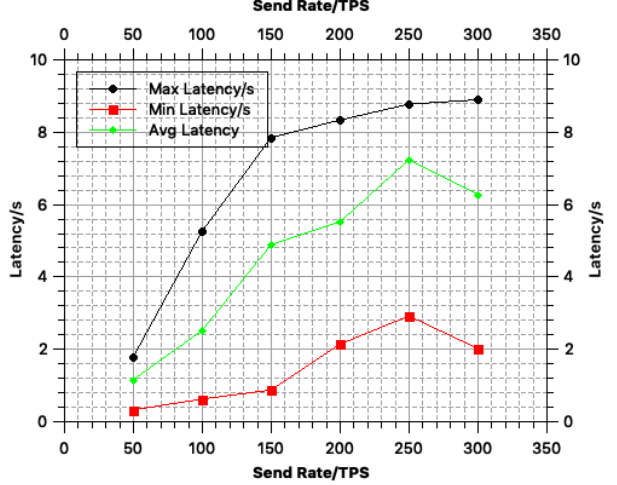
Figure 3. Chaincode invoke